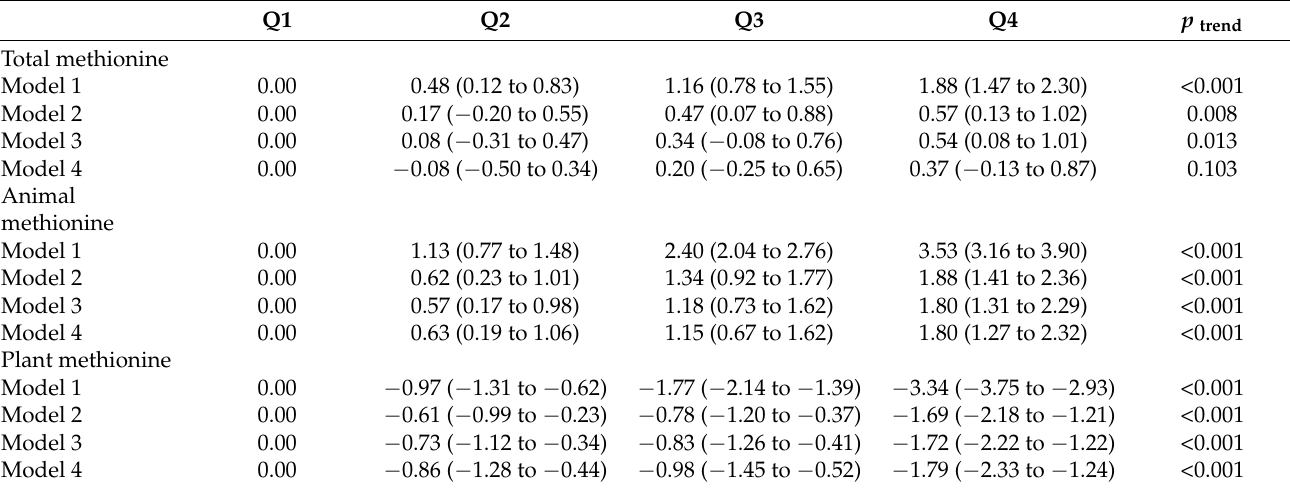
Table 2. Association between total, animal, and plant methionine intake and global cognition scores among adults participating in the